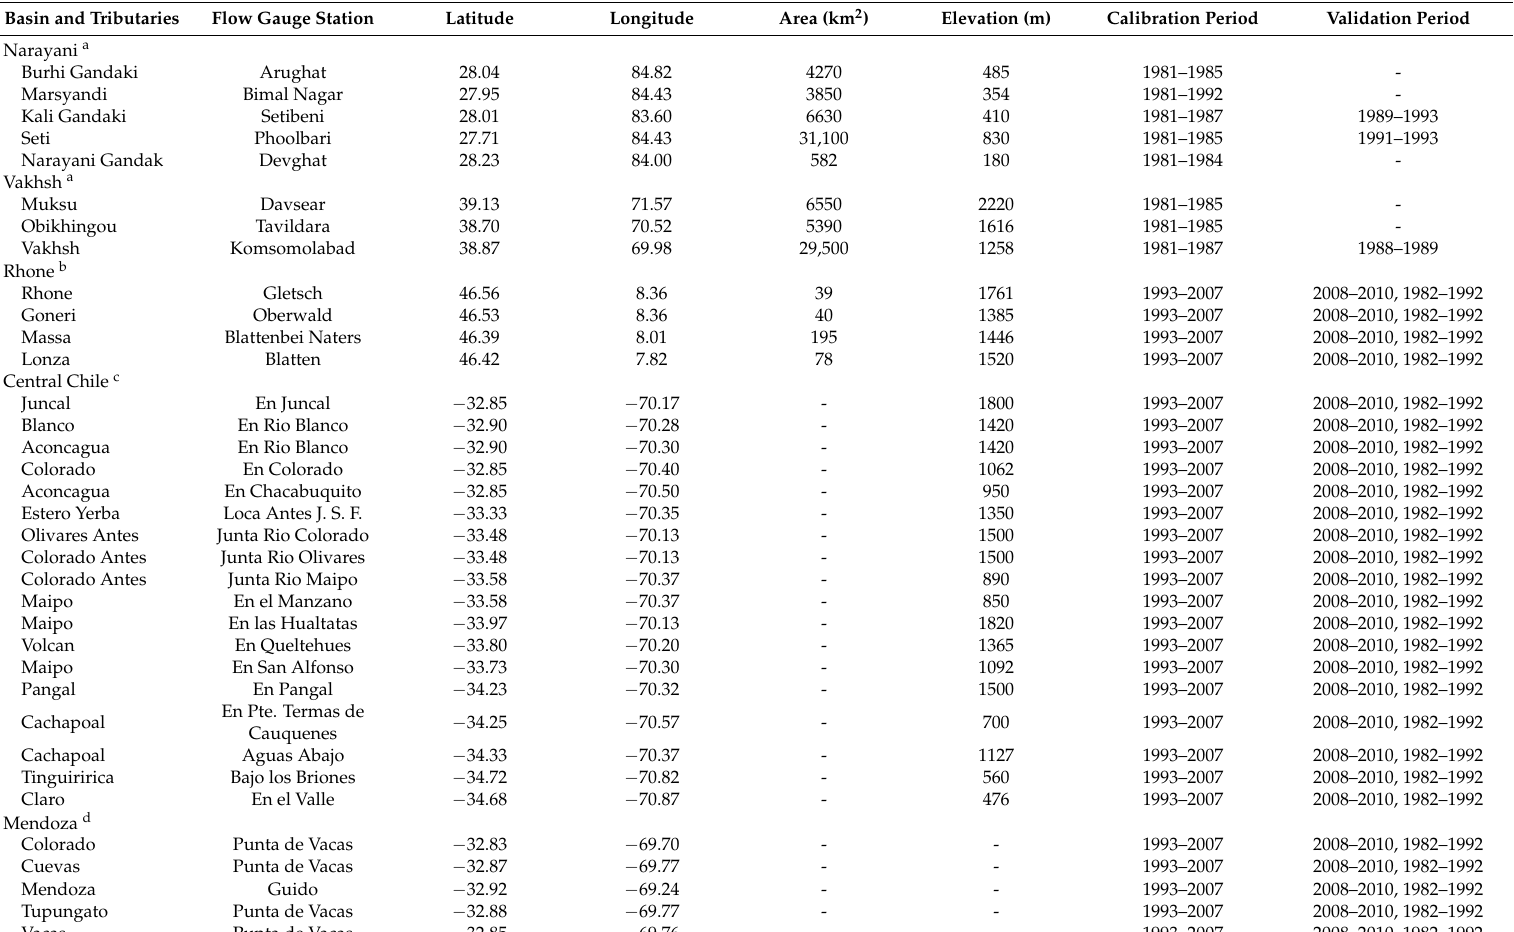
Table 1. All available flow gauge stations with drainage areas for each river basin. Basin and